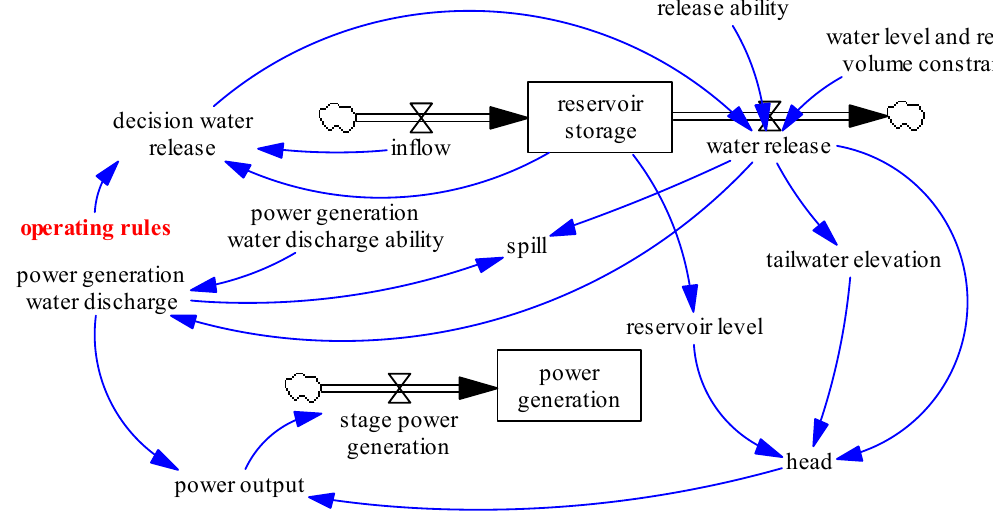
Figure 4. Rough stock and flow diagram for hydropower reservoir operation.